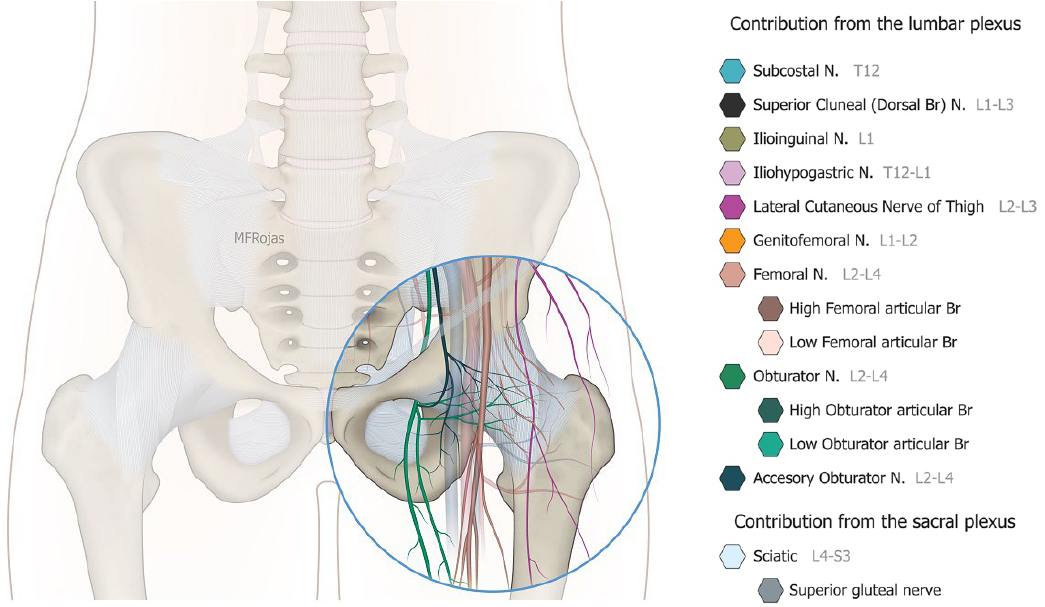
Figure 1. Nerves supplying the hip joint and their relationship to the femoral vessels. Reproduced with permission from Dr Maria Fernanda Rojas Gomez (Bucaramanga, Colombia).